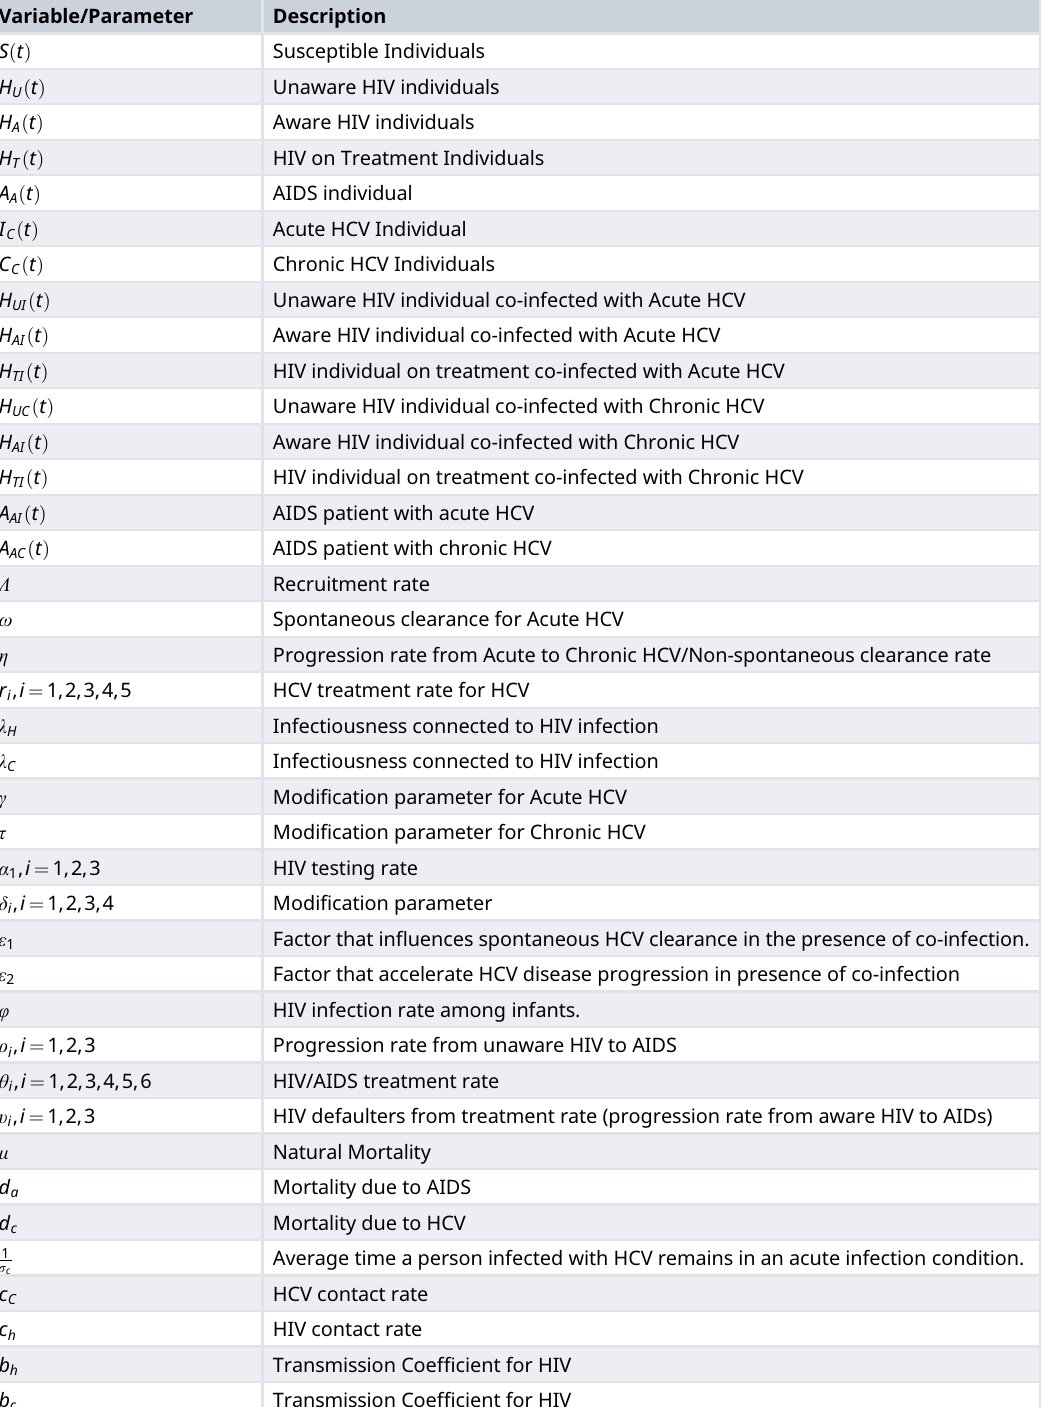
Table 1. List of nomenclature for HIV-HCV Model (4) are described as follows.